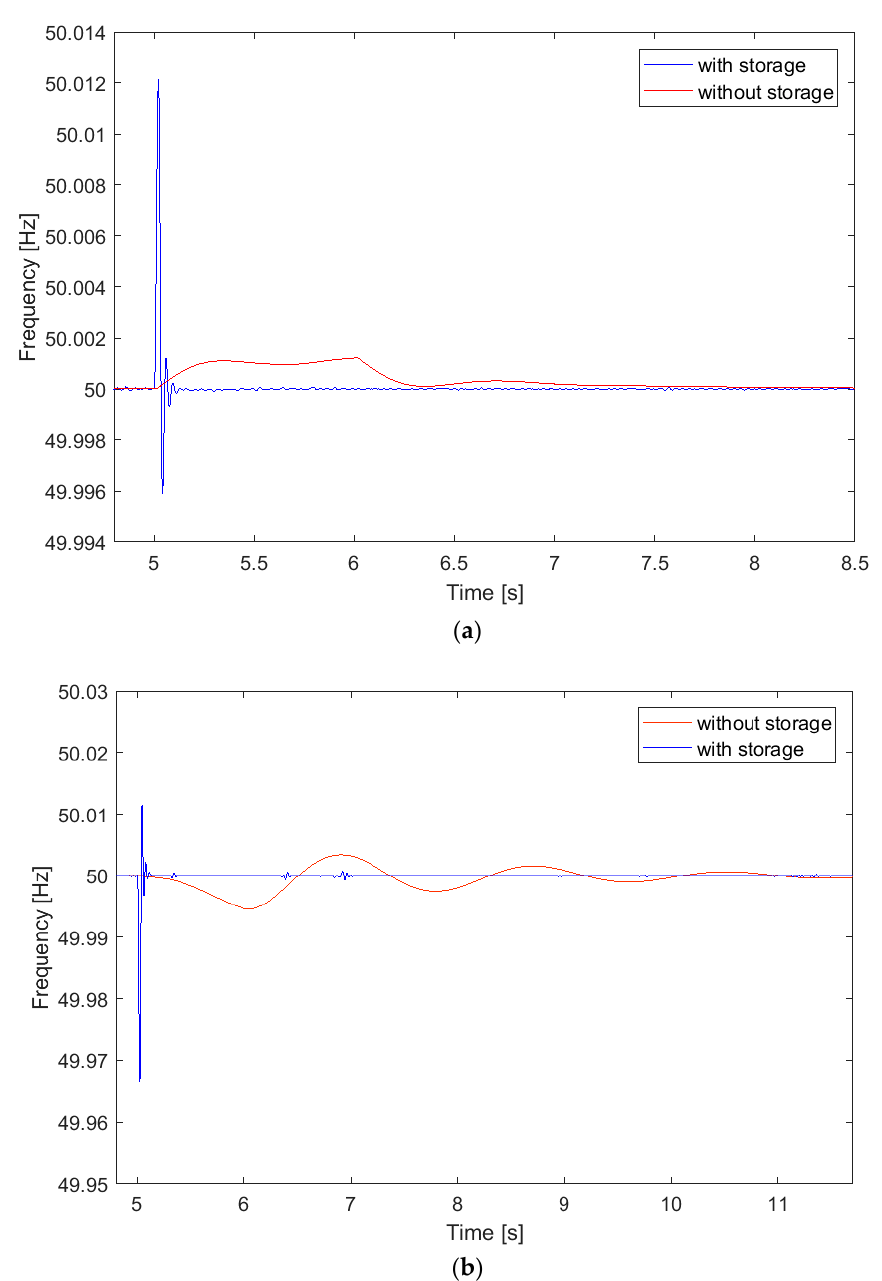
Figure 6. Frequency of the voltage waveform at the PCC concerning HESS integration (blue line) and absence of storage (red line) in case of ( a ) step-up scenario and ( b ) step-down scenario.